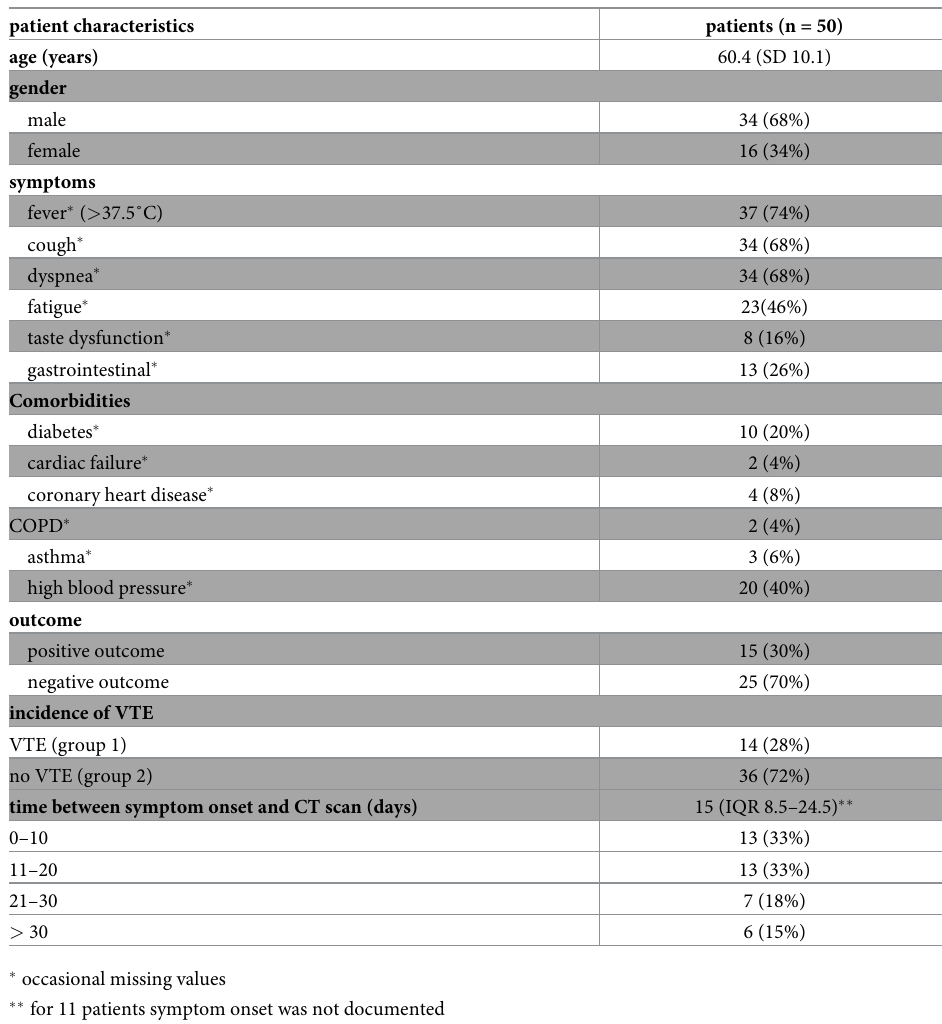
Table 1. Patient characteristics (n =